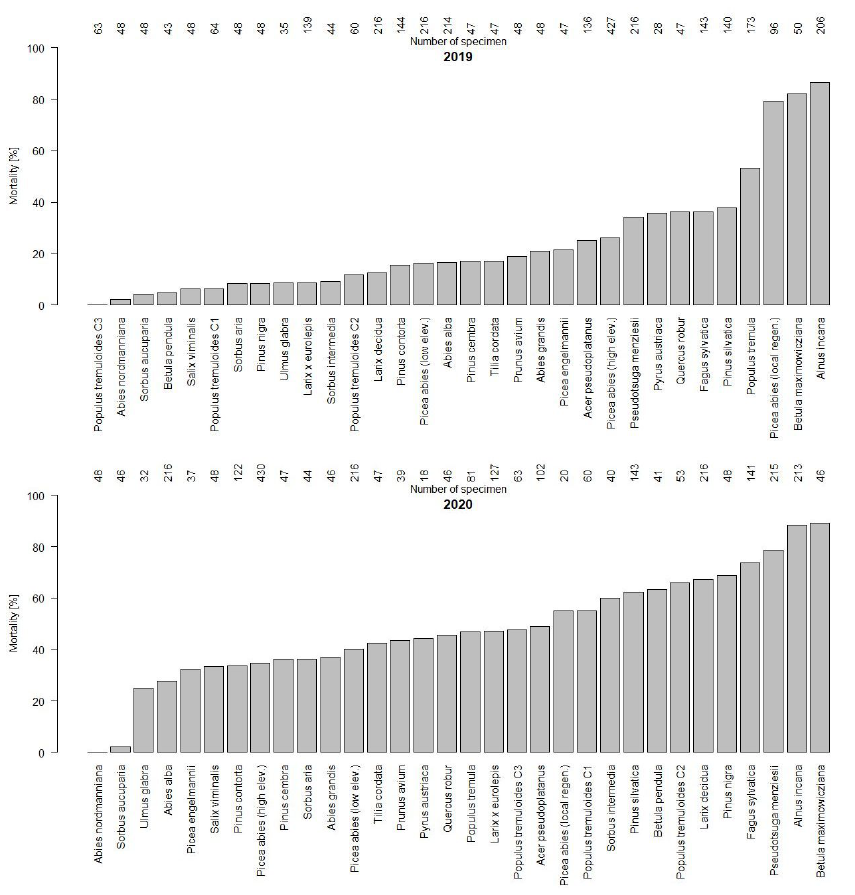
Figure 6. Mortality of tree seedlings in the reforestation experiment, Wechsel, in 2019 and